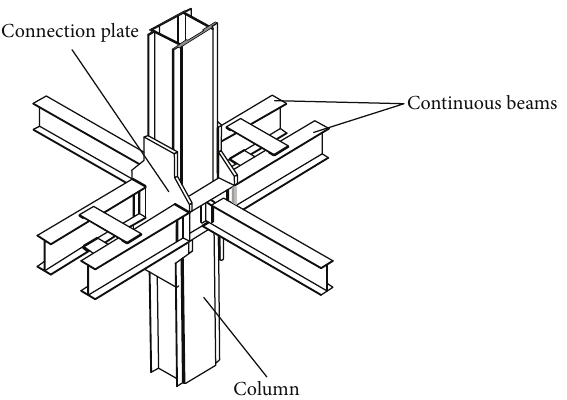
Figure 3: The proposed saddlebag